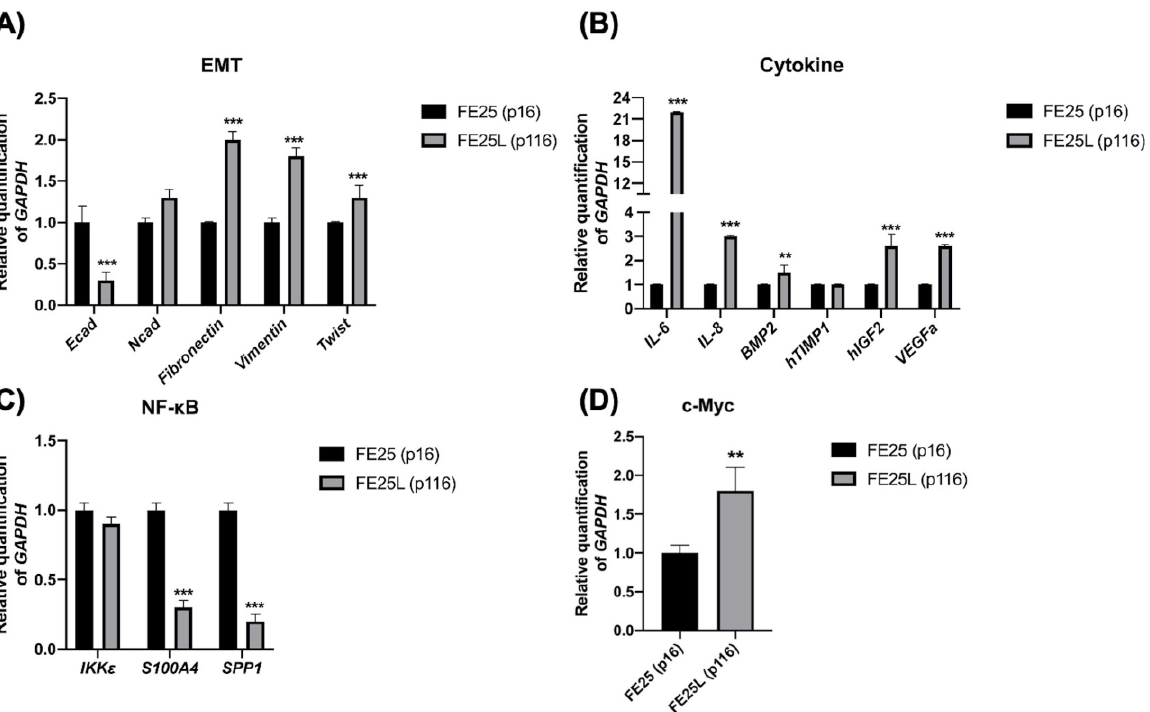
Figure 7. Quantitative RT-PCR validation of gene expression of FE25 (p16) and FE25L (p116) cells. qRT-PCR analysis for ( A ) epithelial-mesenchymal transition (EMT), ( B ) cytokines, ( C ) NF- κB signaling, and ( D ) c-myc is presented for FE25 and FE25L cells ( n = 3 in each group). Error bars represent SD. ** p < 0.01, *** p < 0.001. RQ: relative quantification to GAPDH.